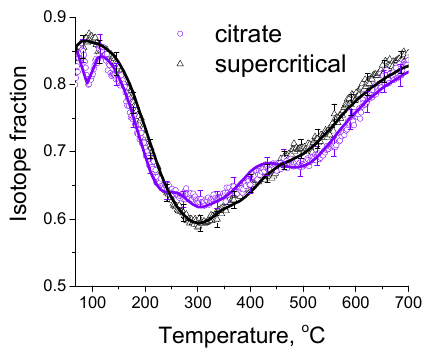
Figure 4. The TPIE curves for Ce 0.75 Zr 0.25 O 2 samples synthesized by citrate method and by supercritical synthesis. Points—experiment, lines—modelling.